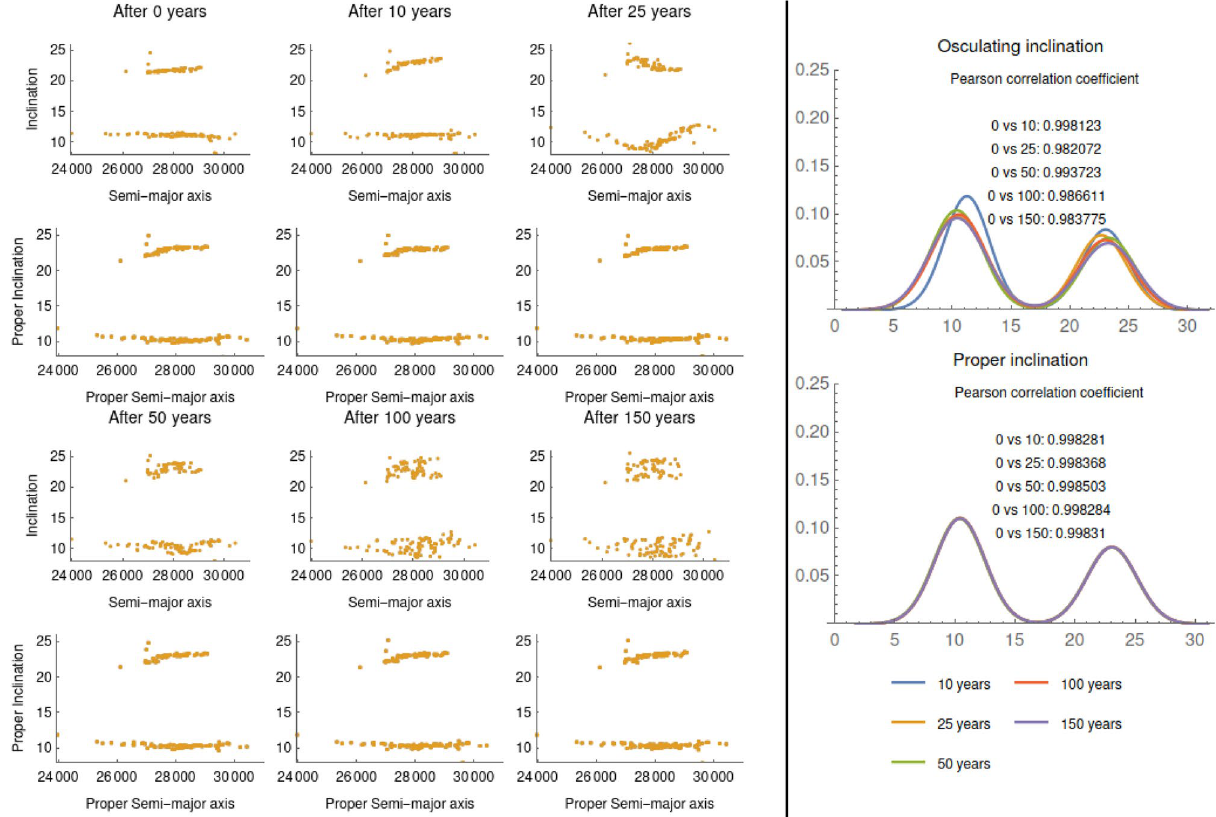
Figure 3. Case of Atlas V Centaur. Comparison between the evolution of the osculating a - i and the evolution of the proper a - i (left). Histogram of the osculating inclination (top-right), and the proper inclination (bottom-